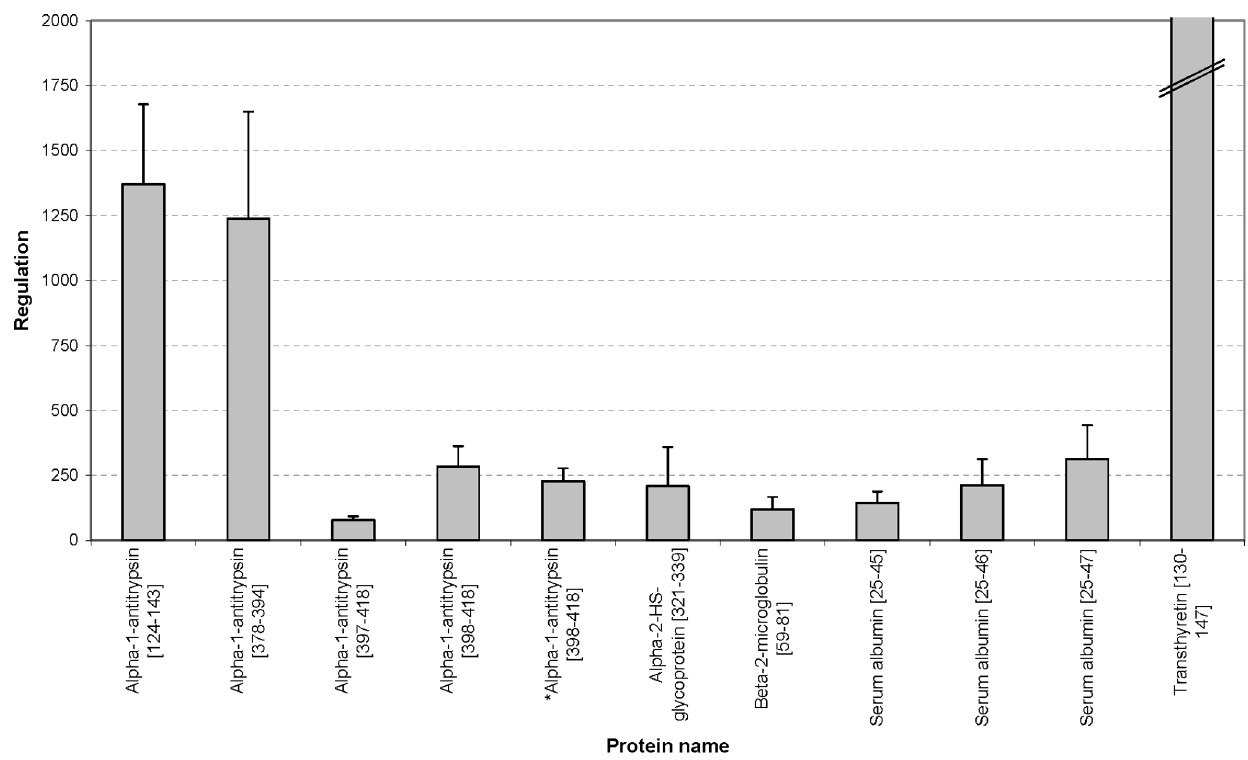
Figure 5. Up-regulation of blood derived protein fragments in urine samples of the PREDICTIONS cohort. Displayed is the regulation of alpha-1-antitrypsin fragments, an alpha-2-HS glycoprotein fragment, a beta-2-microglobulin fragment, serum albumin fragments, and a transthyretin fragment. The asterisk (*) indicate same peptide with one more modification (oxidation).